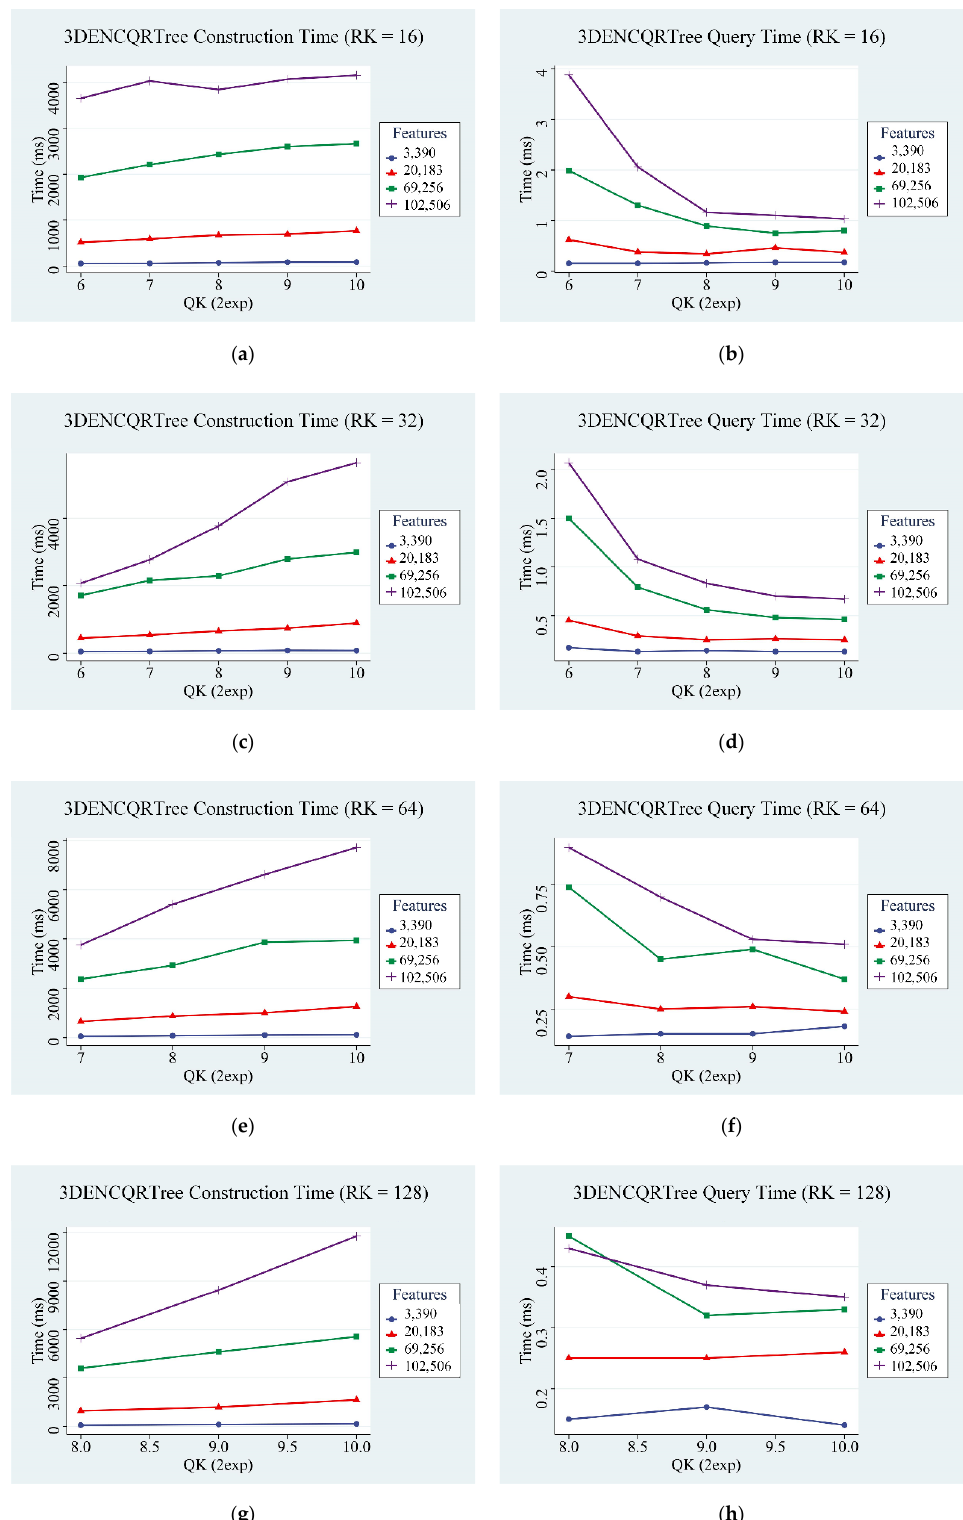
Figure 11. Relationships between construction and query time of 3DENCQR-tree and different thresholds. ( a , c , e , g ) Relationships between the construction of 3DENCQR-tree and different QK thresholds in RK = 16, RK = 32, RK = 64 and RK = 128; ( b , d , f , h ) Relationships between the query of 3DENCQR-tree and different QK thresholds in RK = 16, RK = 32, RK = 64 and RK =